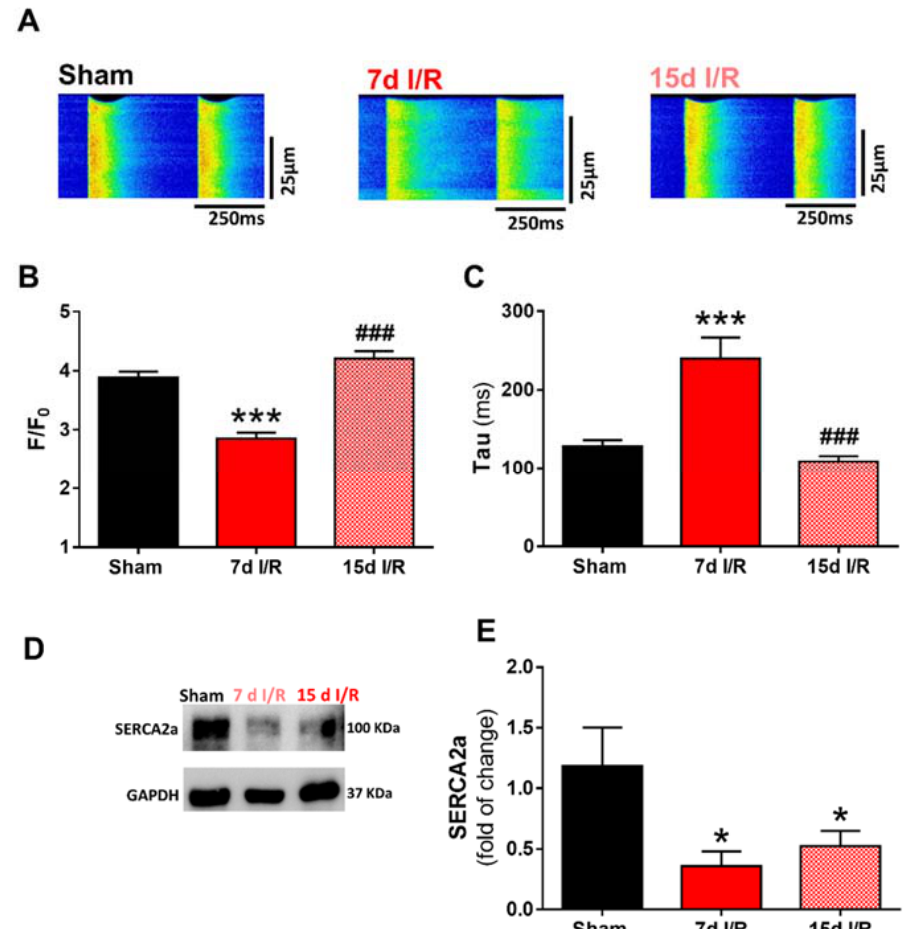
Figure 2. Systolic Ca 2+ transient release in electrically stimulated cardiomyocytes. ( A ) Representative line-scan images of cardiomyocytes from sham-treated mice and from mice subjected to ischemia and reperfusion (I/R) for 7 and 15 days. Cardiomyocytes were electrically stimulated at 2 Hz. ( B ) Mean peak fluorescence Ca 2+ transients (F/F 0 ). ( C ) Decay time constant, Tau (ms). Data are expressed as mean ± SEM. *** p < 0.001 versus sham, ### p < 0.001 versus 7 d I/R; sham ( n = 80 cells, N = 10 mice), 7 d I/R ( n = 61 cells, N = 10 mice), and 15 d I/R ( n = 91 cells, N = 6 mice). ( D ) Representative immunoblots of SERCA 2a and GAPDH and ( E ) quantification of all experiments corresponding to cardiac protein expression. Data are presented as fold of change of sham levels ± SEM (sham = 9; 7 d I/R = 8; 15 d I/R = 8). * p < 0.05 versus sham.